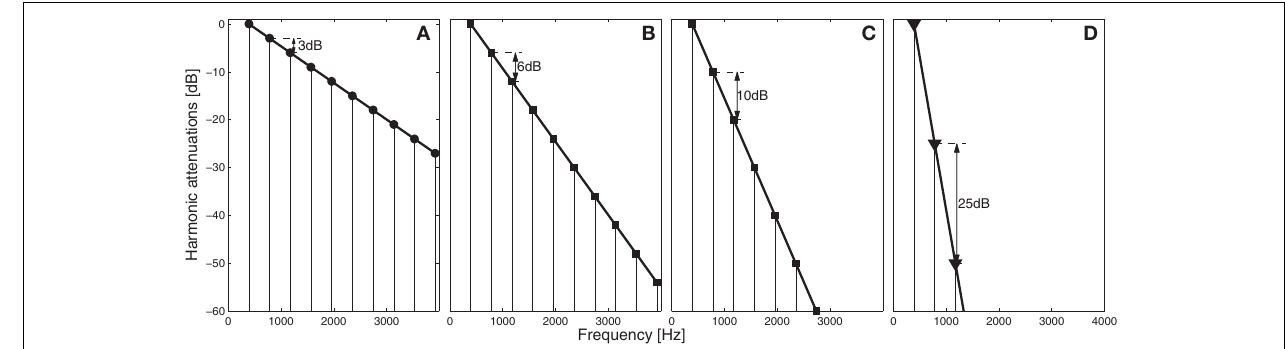
FIGURE 2 | Spectral envelope of the stimuli for different level: (A) 3dB/harmonic (same attenuation than target melody), (B) 6dB/harmonic (3dB additional compared to the attenuation of target stimuli), (C) 10dB/harmonic (7dB additional), and (D) 25dB/harmonic (22dB